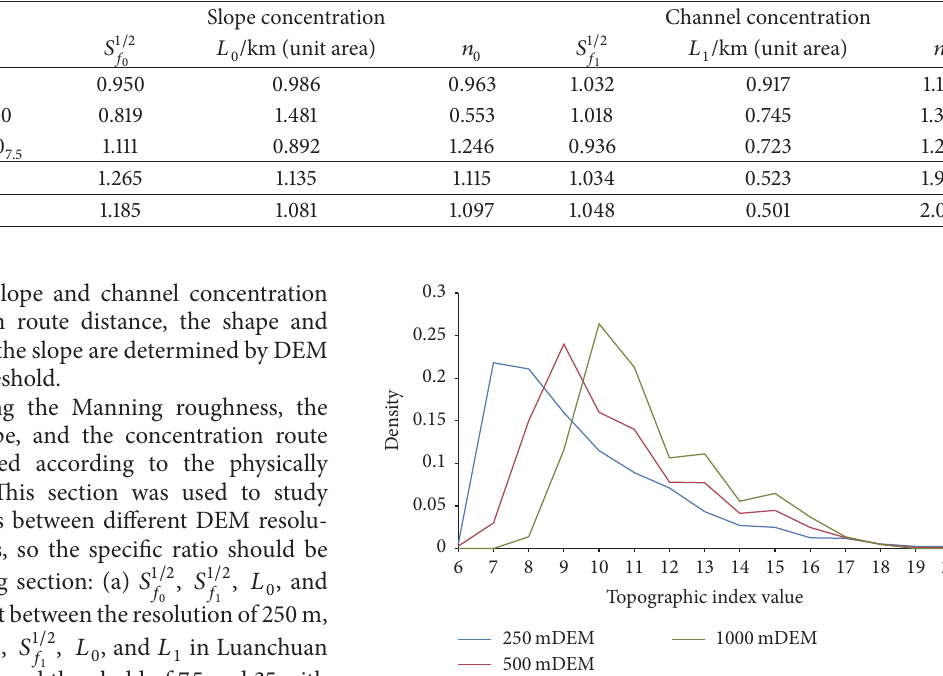
Figure 3: TI of Luanchuan catchment in the DEM resolution of 250 m, 500m, and 1000 m.